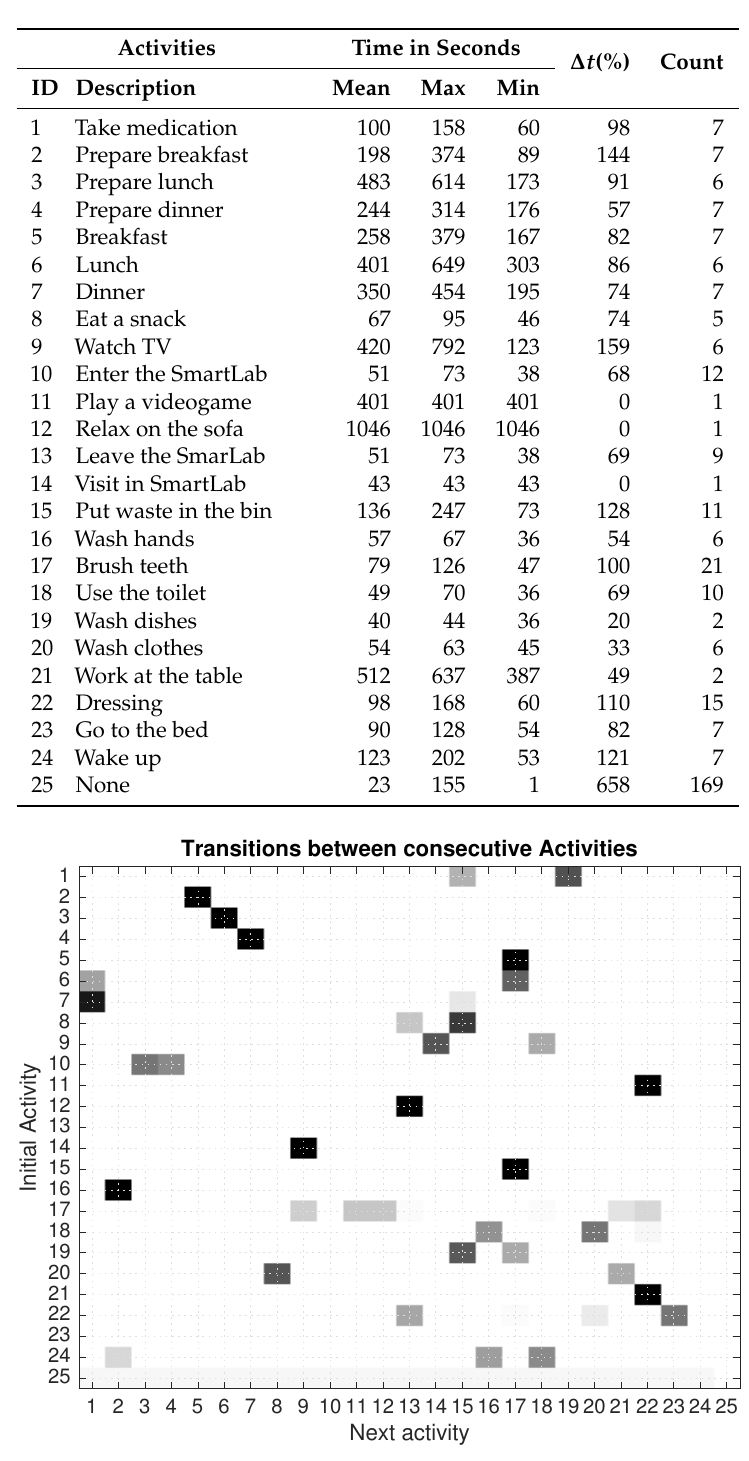
Table 1. Statistics from the training set of activities (7 days).